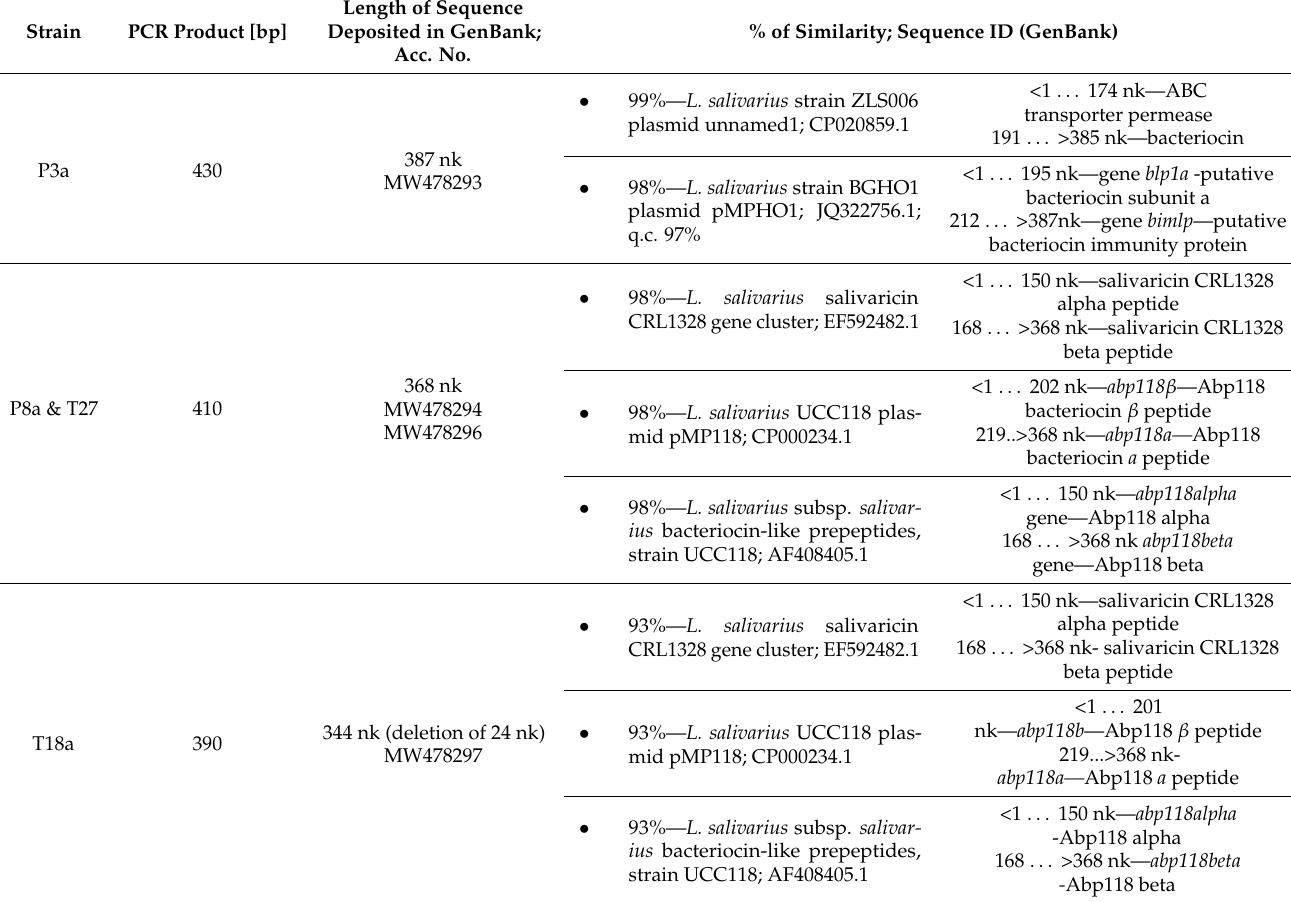
Table 3. BLAST results of sequence analysis of abp118 a + abp118 β bacteriocin amplicons. Length of Sequence Strain PCR Product [bp] Deposited in GenBank; Acc.